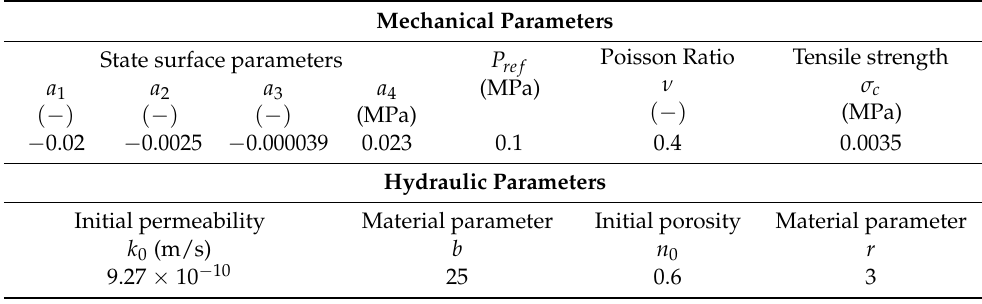
Table A2. Parameters used in the numerical analysis of Barcelona silty